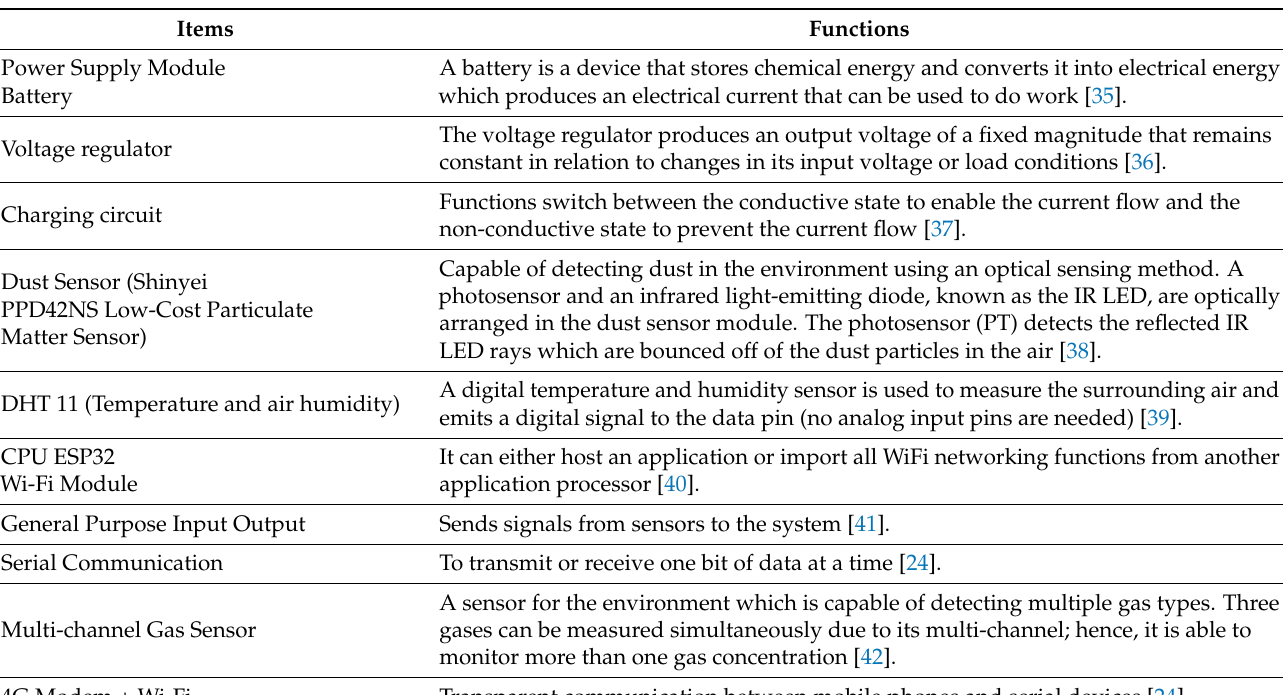
Table 3. Functions of sensor